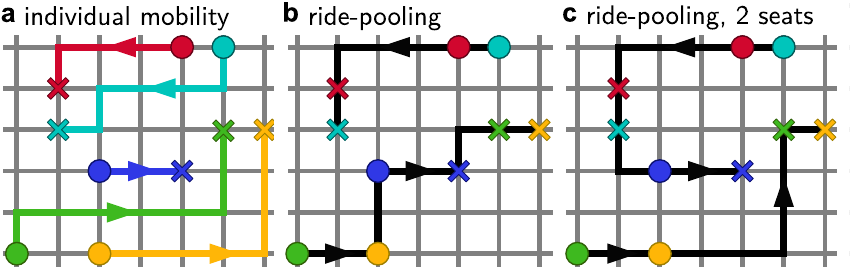
Figure 1. Constraints shape the dynamics of ride-pooling. ( a ) With individual mobility, each person travels from their origin (circle) to their destination (cross) using their own car (colored lines). ( b ) Ride-pooling combines trips along similar routes into the same vehicle. Two vehicles (black lines) starting at the green and cyan origin, respectively, serve all requests. ( c ) Constraints modify the dynamics of the ride-pooling service. If only two customers can be transported by each vehicle at a time, the dark blue trip cannot be served as in panel ( b ). Instead, the routes of the vehicles are modified and the customer is